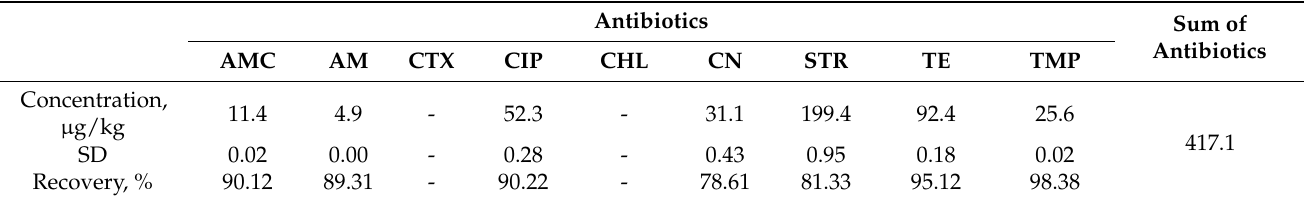
Table 5. Average contents of antibiotics in fish samples ( n = 15).